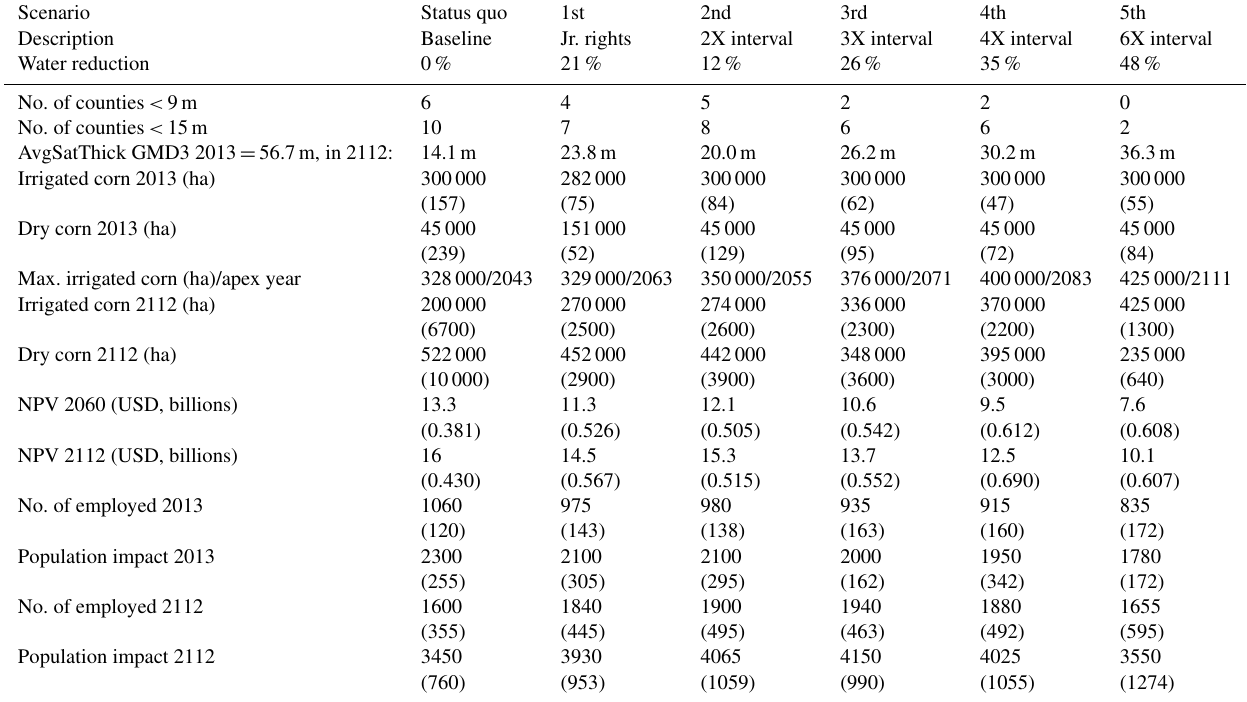
Table 1. Summary of major outcomes from each scenario (standard deviations in